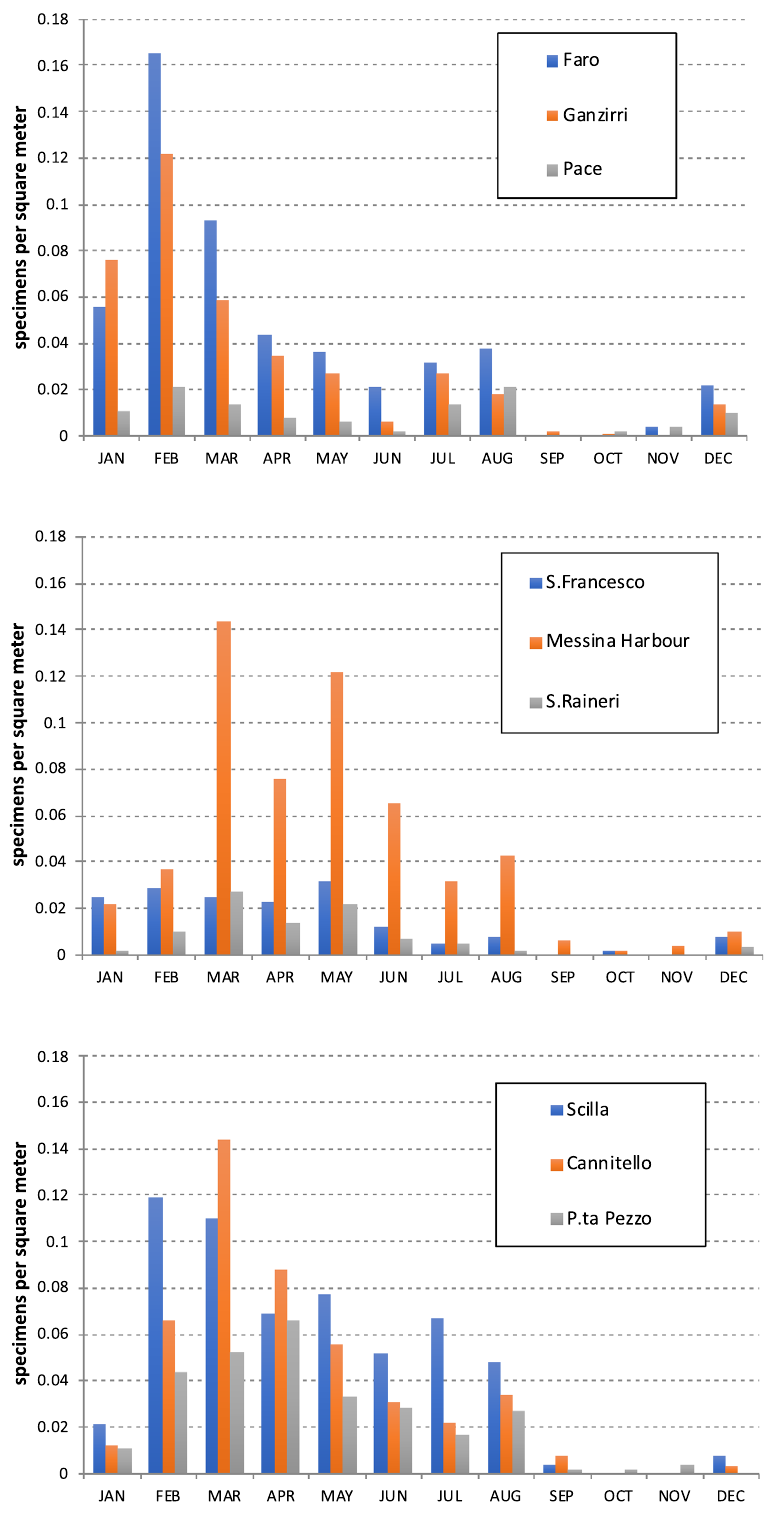
Figure 8. Jellyfish beach strandings: Upper and central panels: Sicilian coast (from N to S); Lower panel: Calabrian coast (from N to